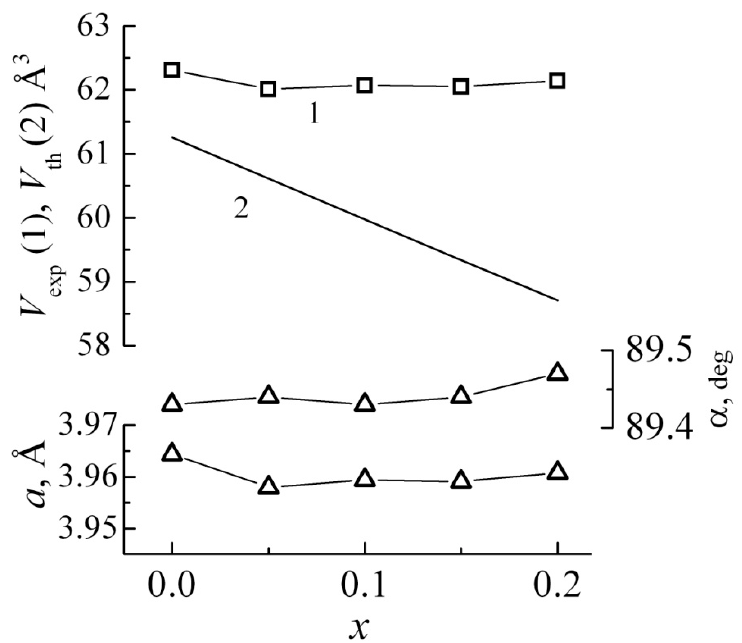
Figure 1. Concentration dependences of the parameters a , α , and volumes V exp and V th of the rhombohedral perovskite cell of Bi 1 − x Er x FeO 3 SS.